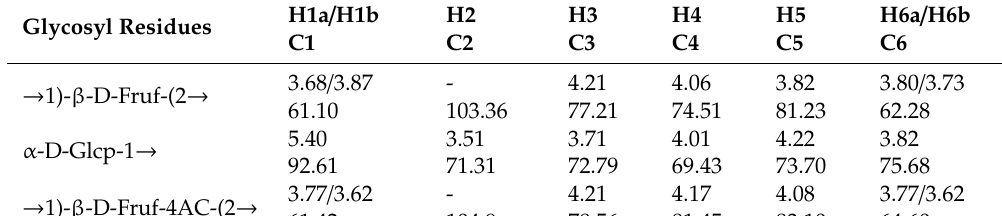
Table 2. 1 H and 13 C nuclear magnetic resonance (NMR) chemical shifts (ppm) for PD1-1. Glycosyl Residues